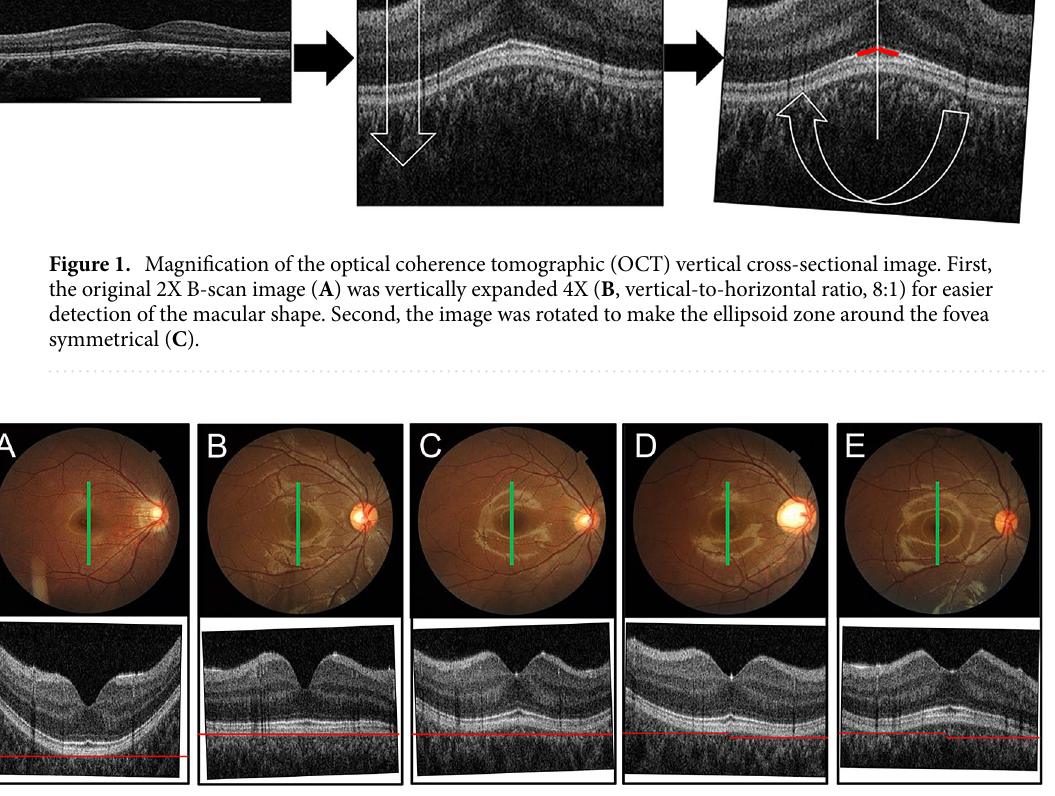
Figure 2. Classification of shapes of macular vertical cross-sectional images. The OCT images were classified based upon its vertical symmetry. Images in ( A , B ), and ( C ) are symmetrical, and images in ( D ) and ( E ) are asymmetrical. The images are then sub-classified into convex-shaped ( A , D upper part), flat-shaped ( B ), dome- shaped ( C , D lower part, E upper part), and concave-shaped ( E lower part) according to the retinal pigment epithelium curvature. Red lines are horizontal straight